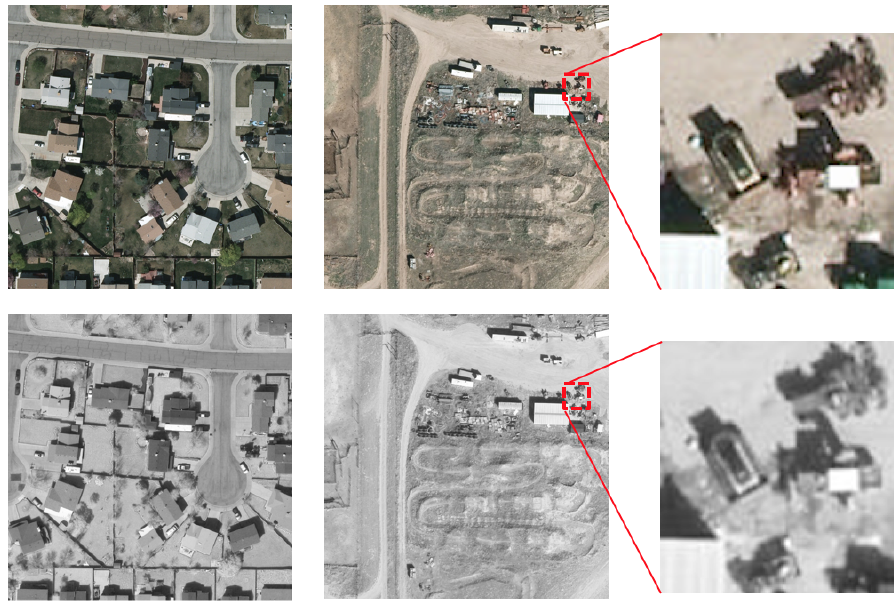
Figure 3. Illustrations of the VEDAI dataset [31] in color version ( top ) and infrared version ( bottom